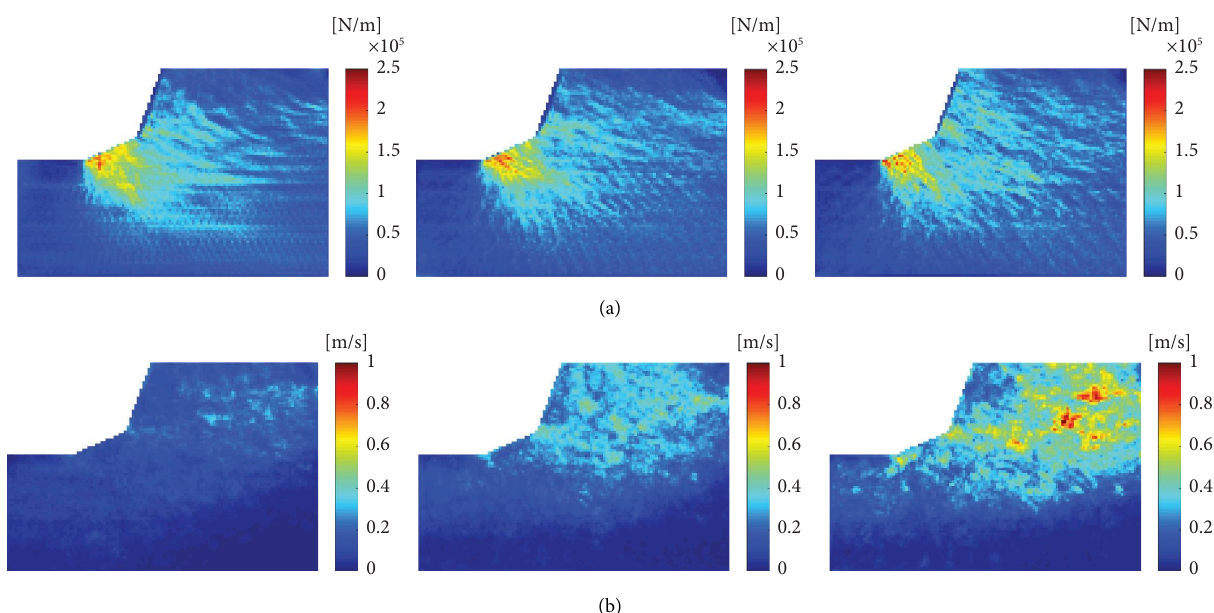
Figure 8: Averaged normal contact force (a) and averaged relative velocity (b) with various cutting speeds (30, 60, and 90RPM from left to